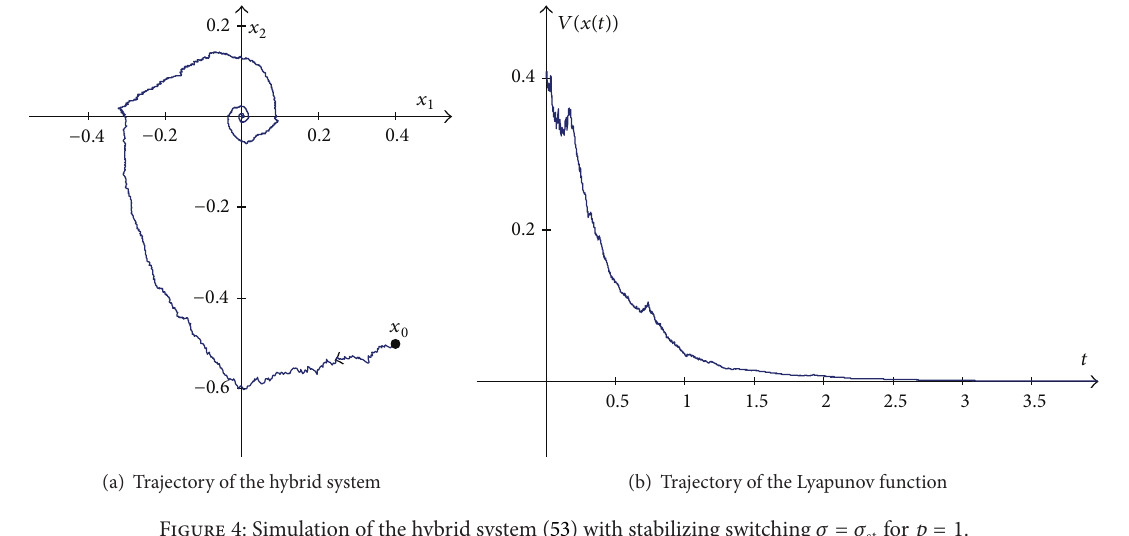
Figure 4: Simulation of the hybrid system (53) with stabilizing switching 𝜎 = 𝜎